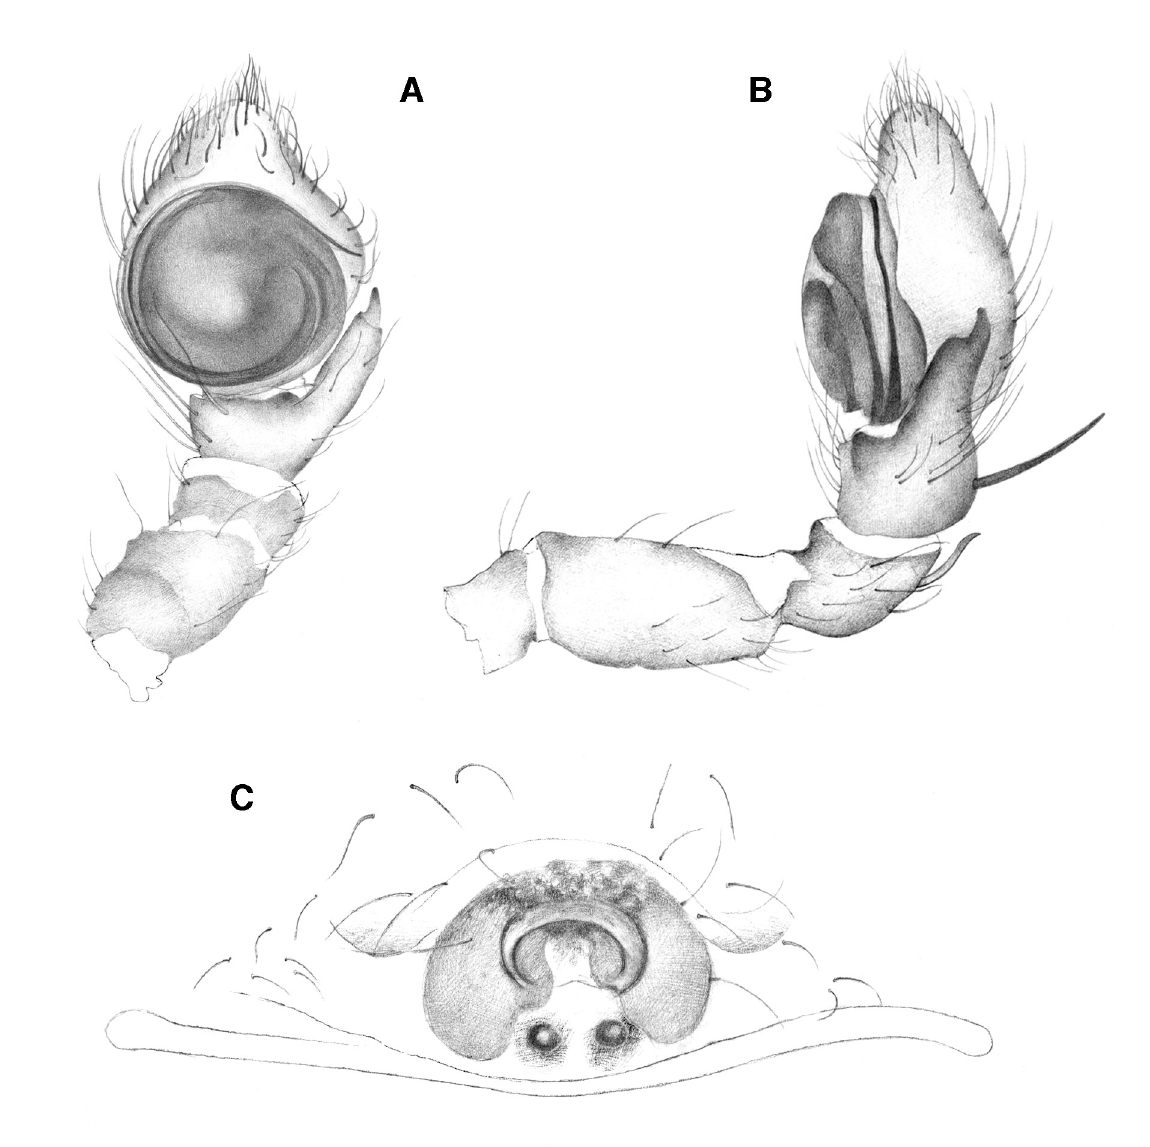
Fig. 1. Mecaphesa inclusa (Banks, 1902). A . ♂ palp, ventral view. B . ♂ palp, retrolateral view. C . ♀,